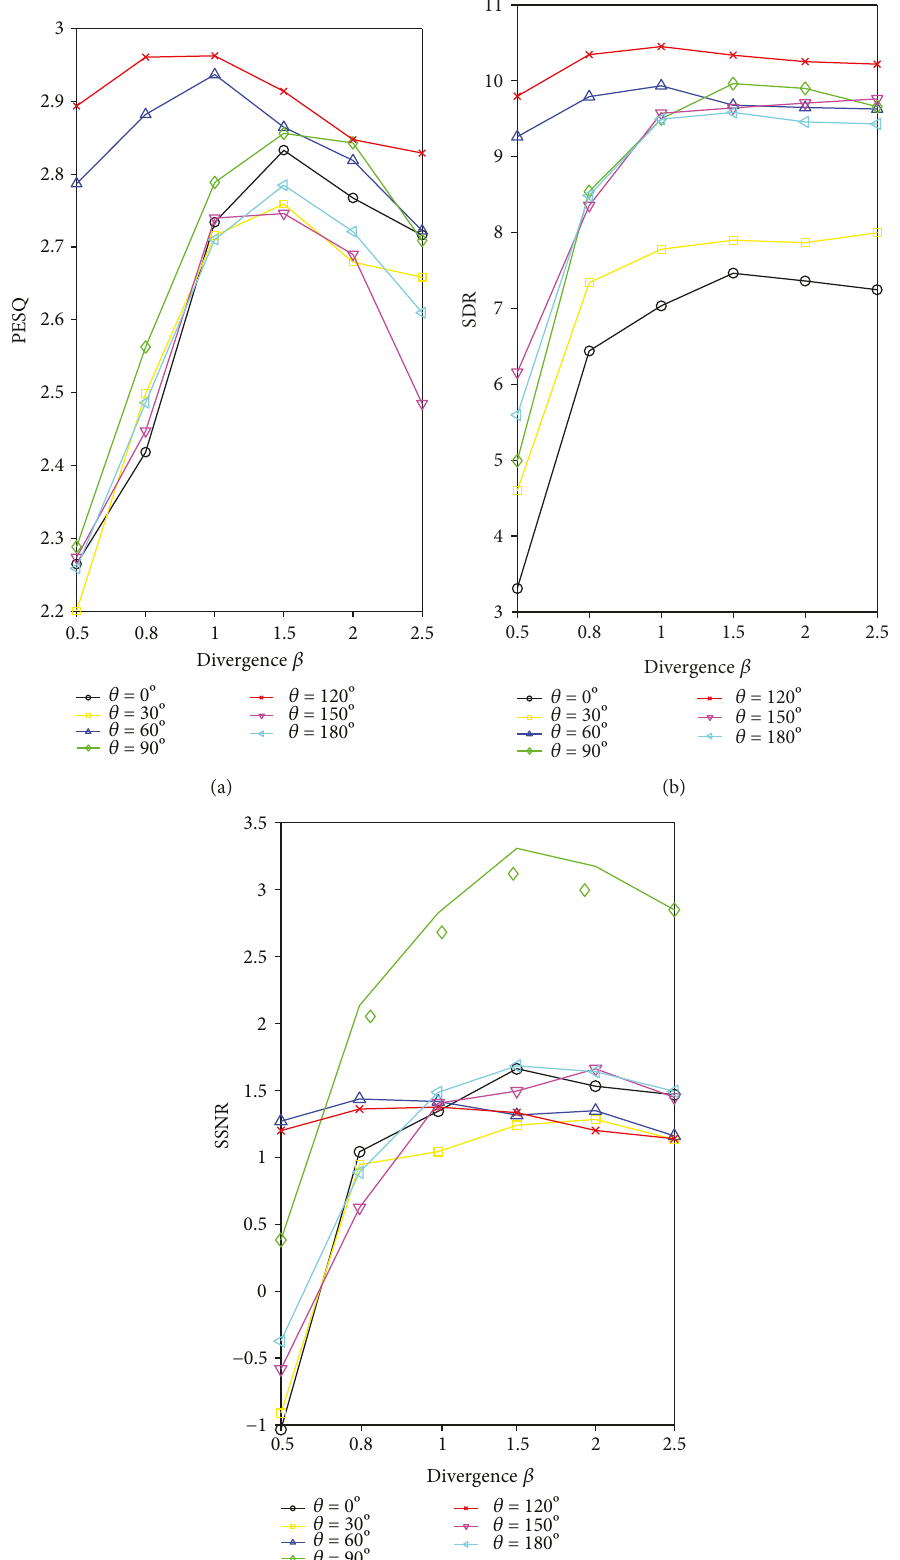
Figure 5: PESQ, SDR, and SSNR values of the enhanced speech from Factory1 noise at 0dB input